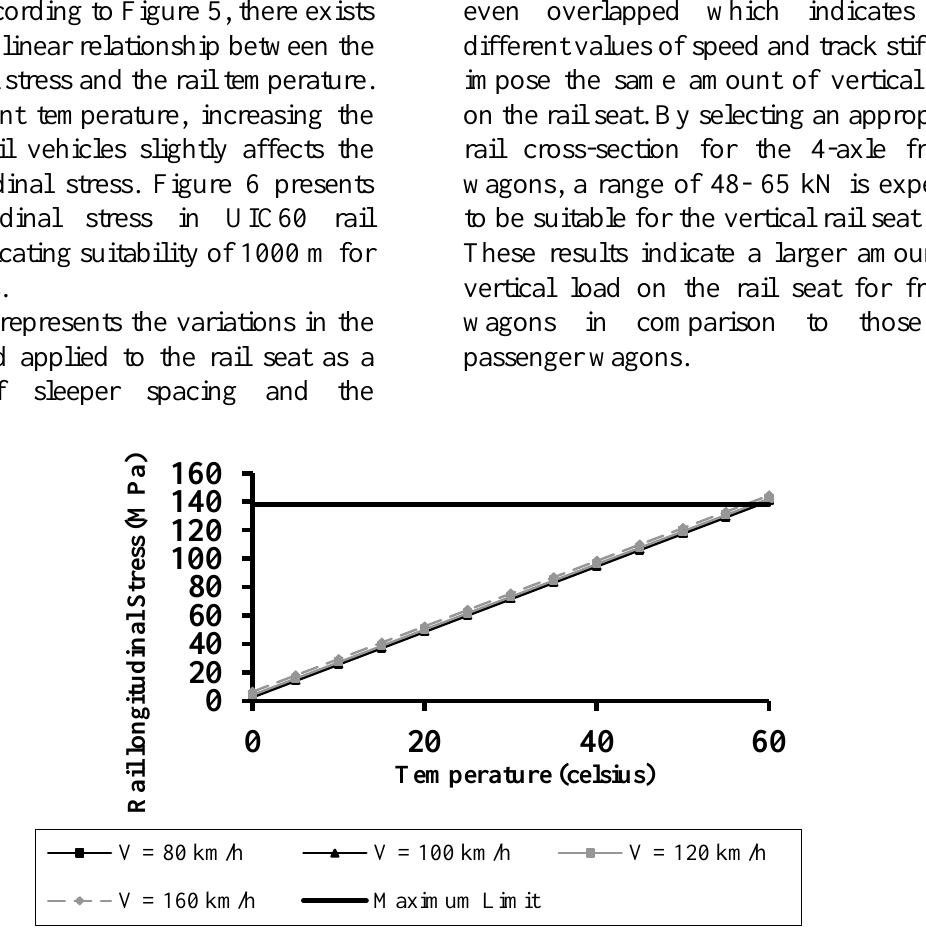
Fig. 5. Longitudinal stress variation along the UIC60 rail due to temperature variation for different wagons.